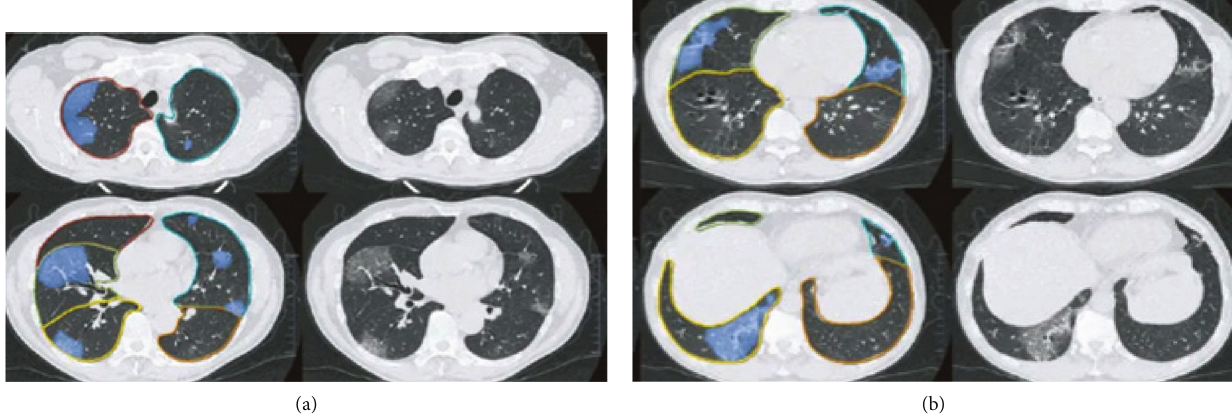
Figure 4: Human CT image segmentation. (a) Before scanning. (b) After